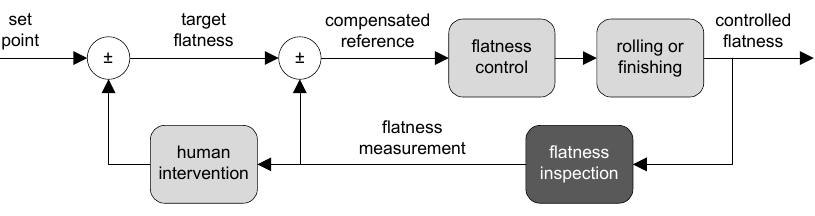
Figure 1. Feedback block diagram of a flatness control